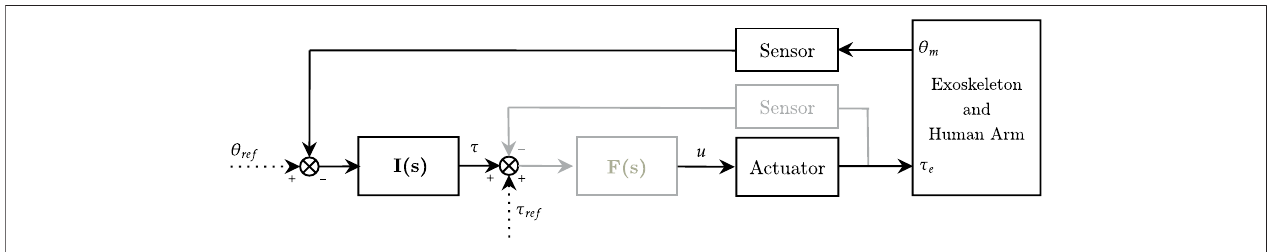
FIGURE 3 | Impedance control scheme in the joint-space. Implicit (black) and explicit (black and gray). I ( s ) is the impedance controller, F ( s ) is the force controller (only explicit). θ ref and τ ref represent respectively reference angular position and torque, while u refers to the motor corrent control signal.